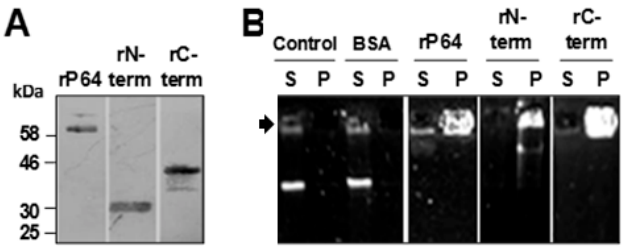
Figure 1. P64 and its N-terminal (N-term) and C-terminal (C-term) domains condense Spodoptera frugiperda ascovirus-1a genomic (g)DNA. ( A ) SDS-PAGE showing purified 6x-histidine tagged proteins (rP64, rN-term, rC-term) used in the assays. ( B ) Examples of results of electrophoretic mobility shift assays (EMSA) showing the presence of SfAV-1a gDNA in supernatants (S) or pellets (P) after centrifugation following incubation without protein or with bovine serum albumin (BSA), rP64, rN-term and rC-term; ~2 µg of each protein and 15 ng of gDNA were used in each assay. Arrowhead indicates position of wells in agarose gels.